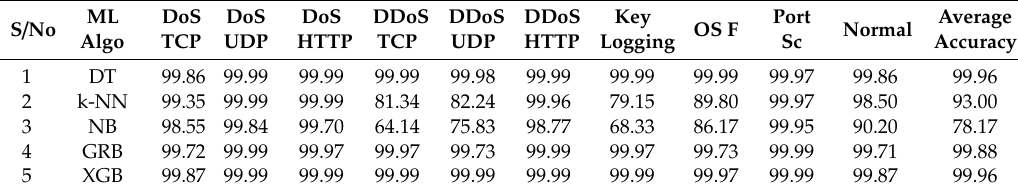
Table 8. Accuracy summary of the multiclass classification.